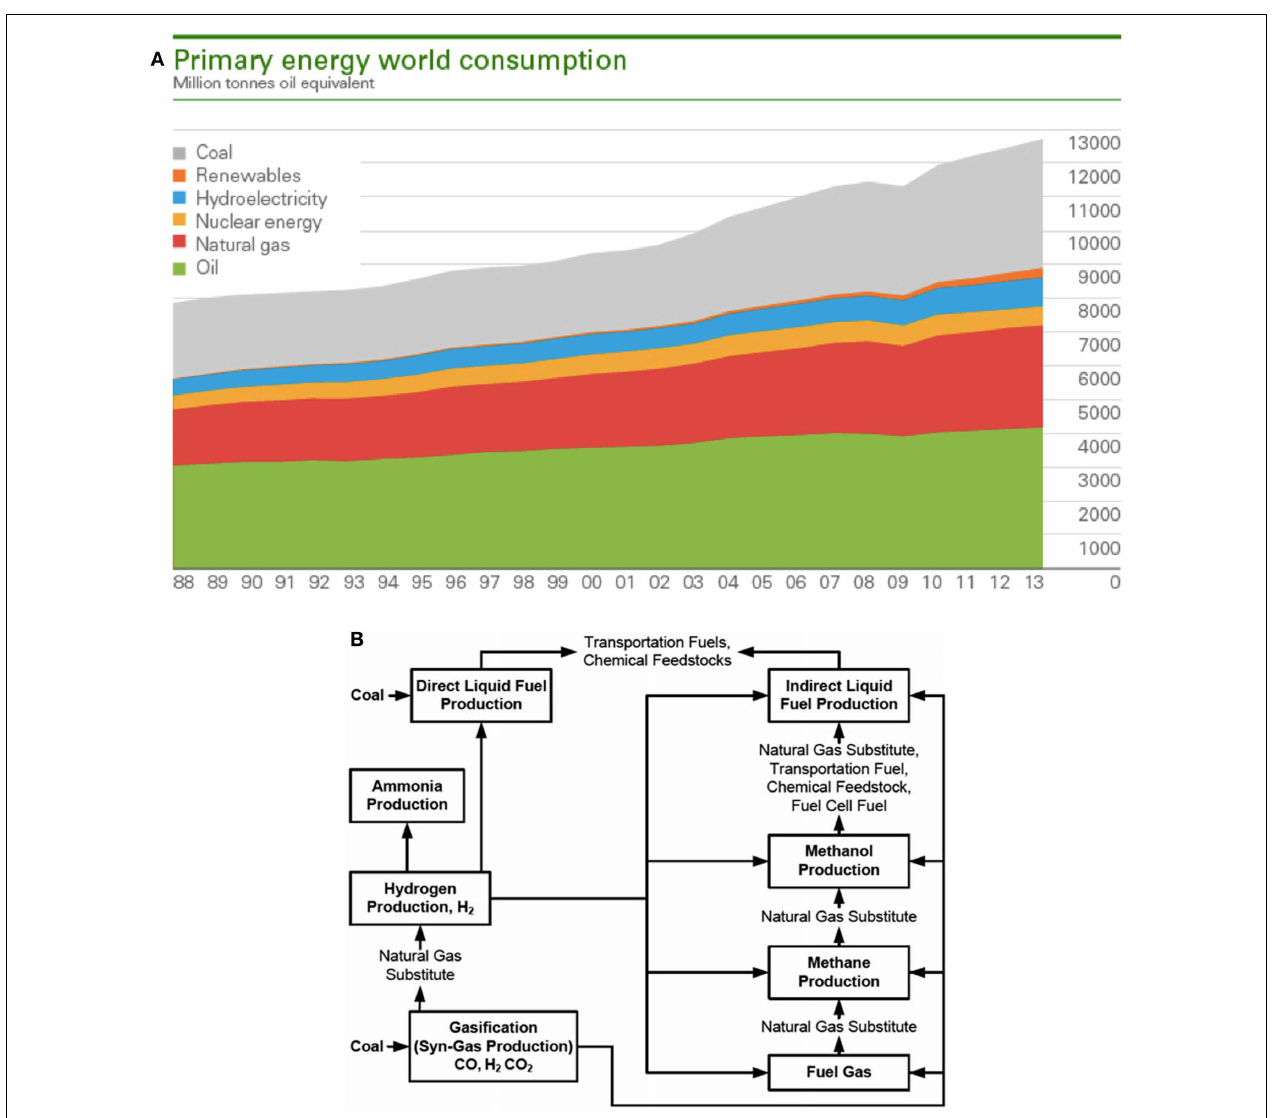
FIGURE 1 | (A) Primary energy world consumption (million tons of oil equivalent) is shown. Fossil fuels represent a total of 87% of global energy consumption and are steadily rising (British Petroleum, 2013). (B) Schematic of fuel and chemical products produced from CO and H 2 via the Fischer–Tropsch process, exhibiting the flexibility in coal (Wilcox,